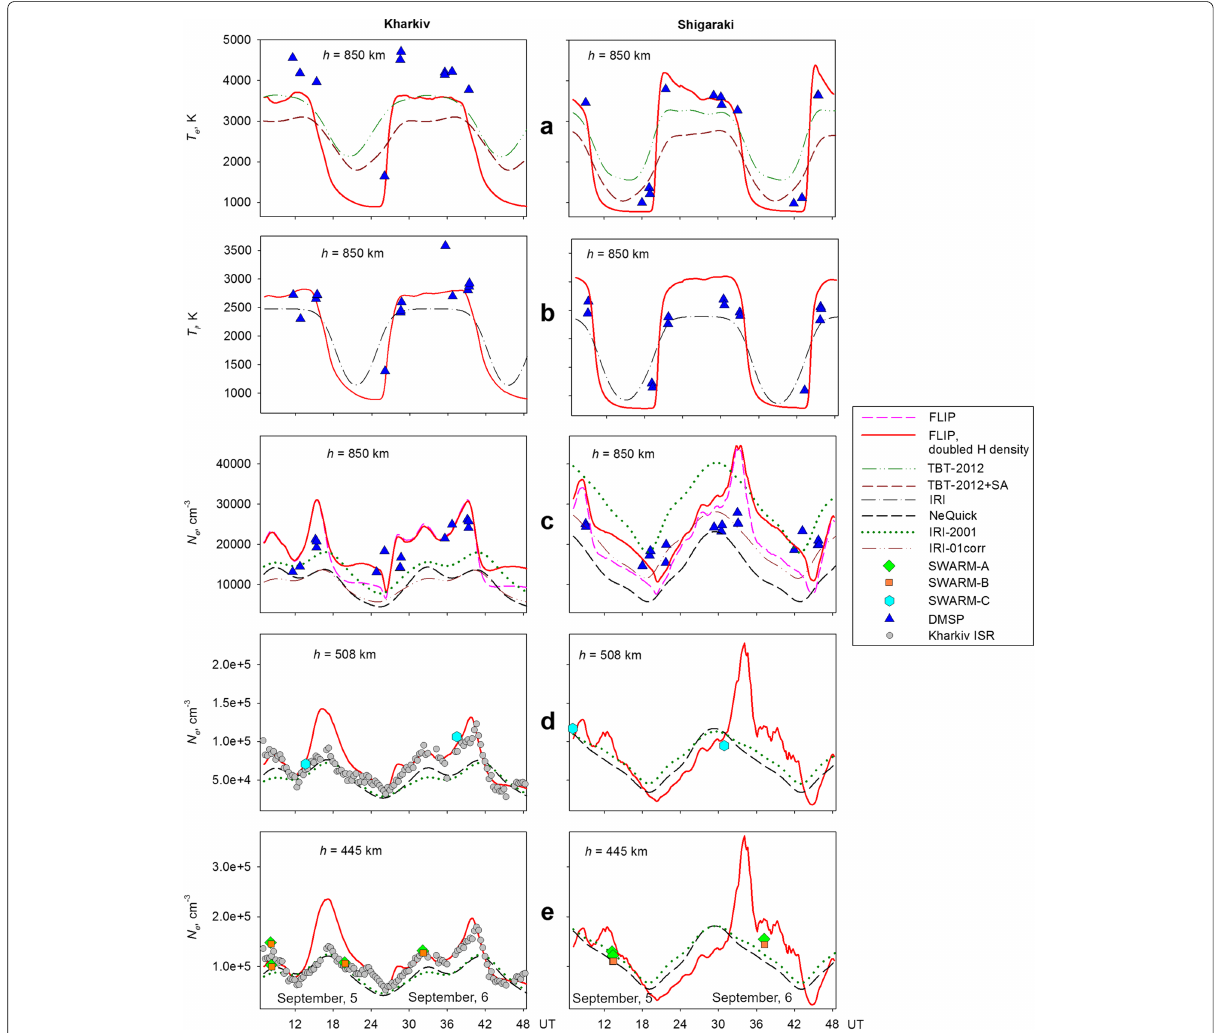
Fig. 4 Diurnal variations of electron and ion temperature, and electron density at 850 km ( a – c ), electron density at 508 km ( d ), and at 445 km ( e ). Solid red line is the FLIP model simulation with the h m F2 constraint together with doubled NRLMSISE-00 H density, dashed pink line – the same but with NRLMSISE-00 H density. Gray circles denote KhISR, blue triangles – DMSP, green diamonds – SWARM-A, orange squares – SWARM-B, cyan hexagons – SWARM-C observations respectively. On panel ( a ), dashed brown and dash-dotted green lines denote T e variation from TBT-2012+SA and TBT-2012 models respectively. Dash-dotted black line on panel ( b ) shows T i variation from IRI-2016 model. On panels ( c – e ), dashed black line denotes NeQuick, dotted green – IRI-2001, dash-dotted brown lines – IRI-01corr models calculations respectively. The models predictions